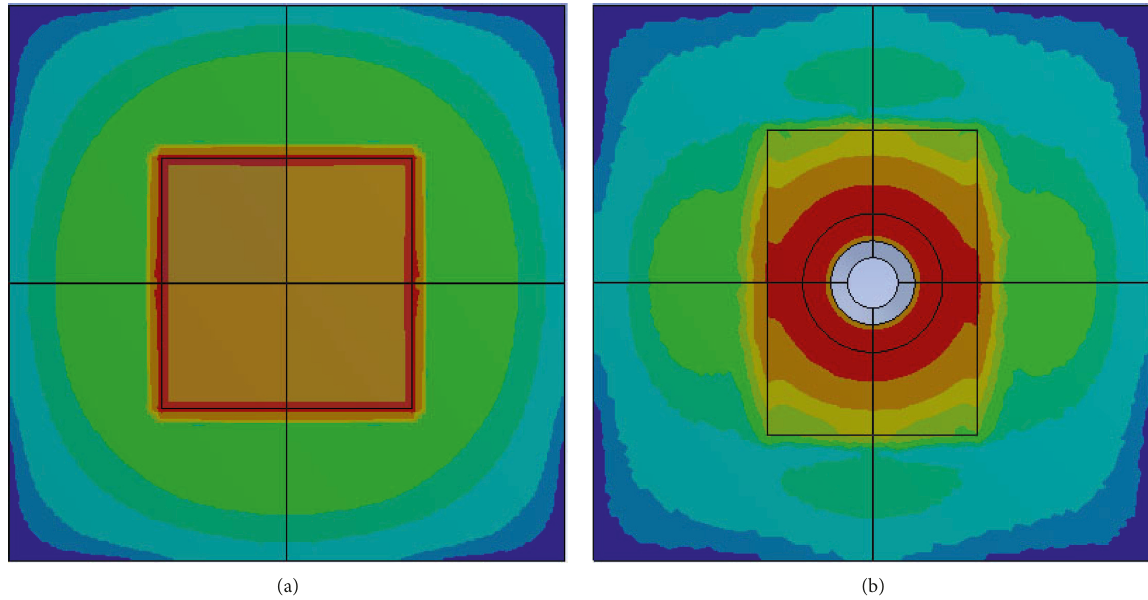
Figure 9: Comparison of von Mises stress depending on the anchorage shape. (a) Model S and (b) Model A.